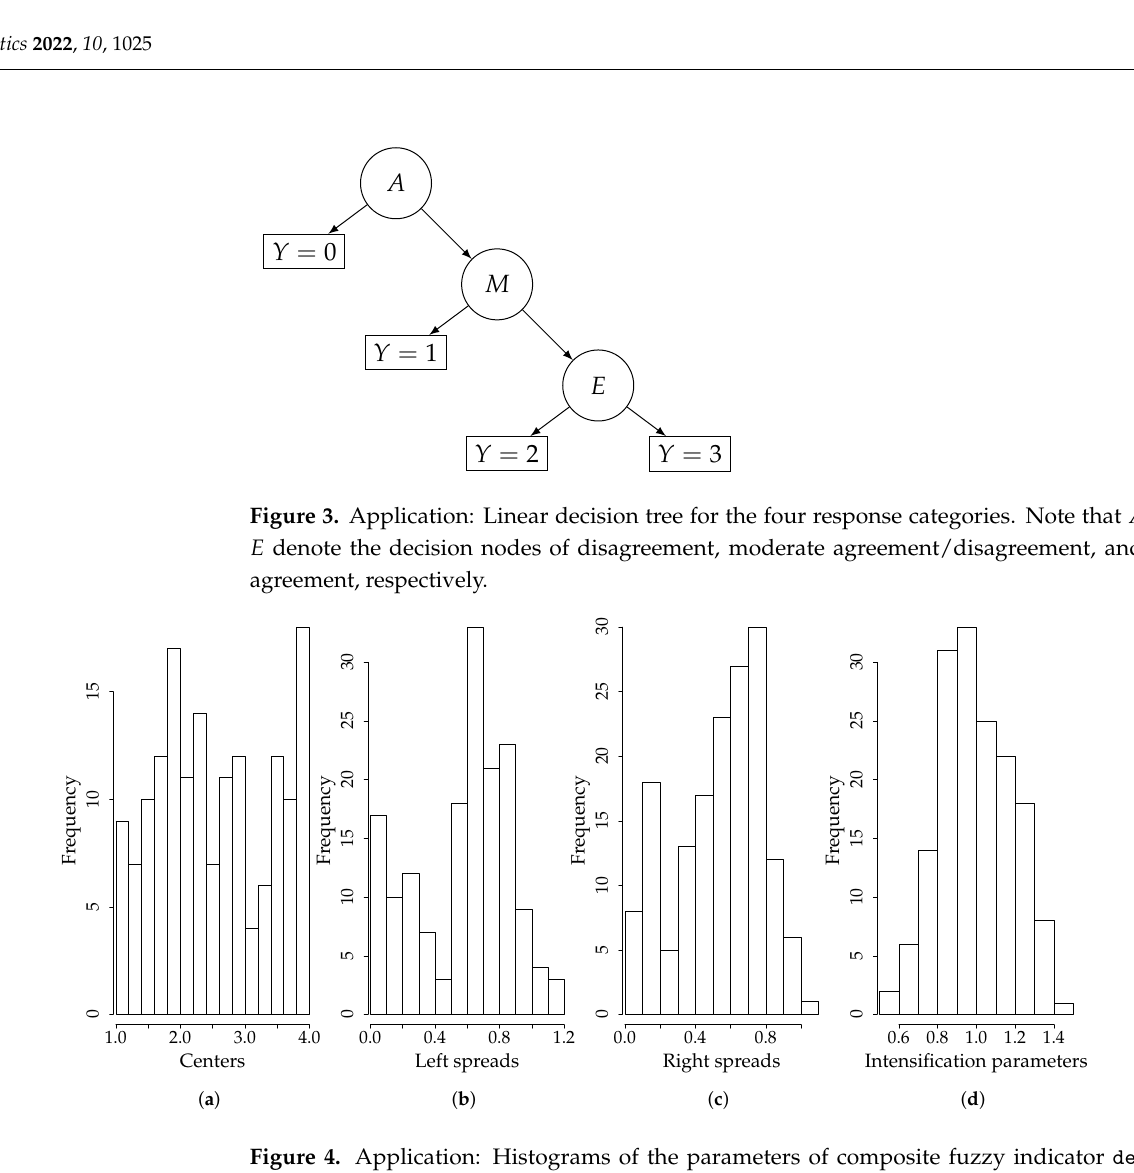
) distribution; (c) : l i − i ) i